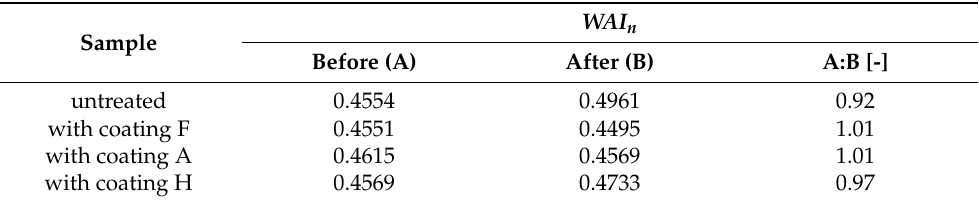
Table 6. Comparison of the mean normalized values of WAI n before and after freeze–thaw cycling